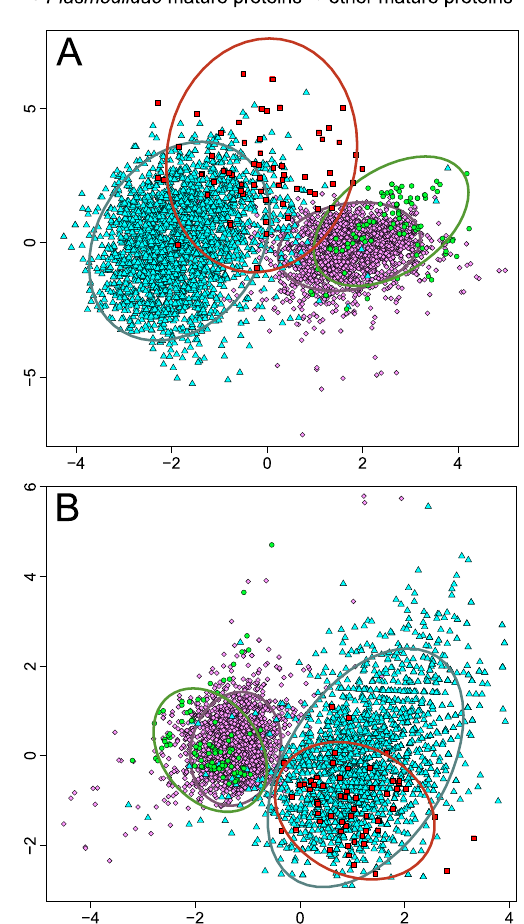
Figure 7. Principal Component Analysis performed on raw amino acid composition ( A ) and amino acids encoding into groups ( B ) for SPs and mature proteins from Plasmodiidae and other organisms. SPs from Plasmodiidae create a set, which is quite distinct from other SPs according to raw amino acid composition. However, the application of amino acid encoding chosen in cross-validation makes these sets similar but still supporting a significant difference between SPs and mature proteins. Concentration ellipses cover 95% of points from a given